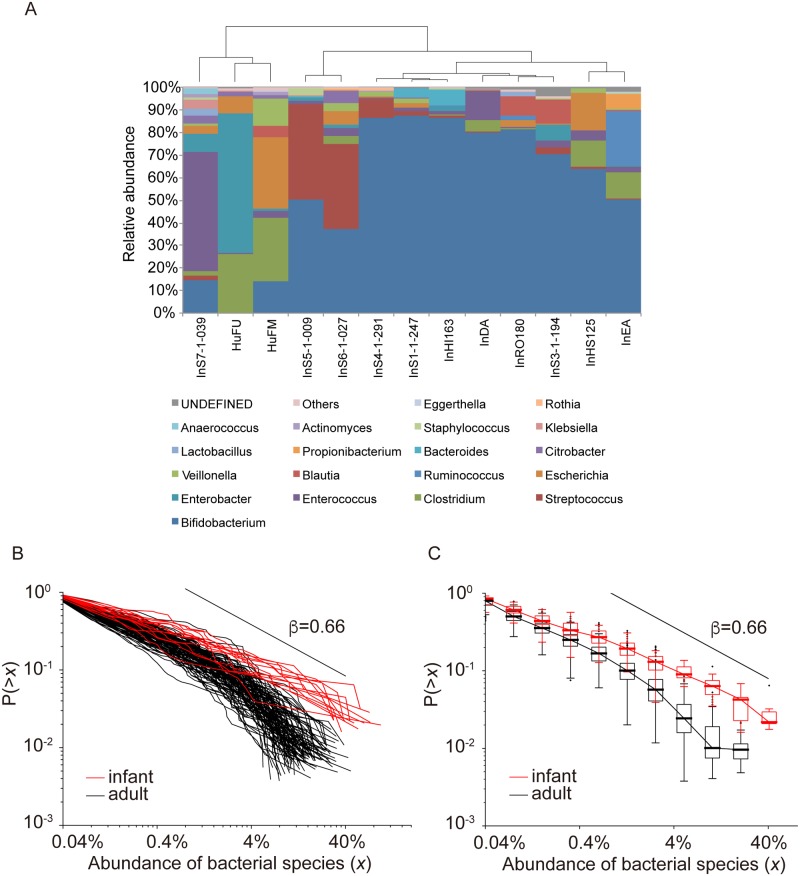
CRADs of the human infant gut microbiome.A: Clustering of the 13 human infant samples at the genus level. Hierarchal clustering is performed at the genus-level abundance of the human infant samples. Each genus is shown in a different color. B: Individual CRADs of gut microbiomes of 13 human infants based on the OTU-level composition. The CRADs of the gut microbiomes of the 13 infants (red) and the 104 healthy Japanese adults (black) are shown. C: Median CRADs of the same samples as those in (B). The CRADs of the gut microbiomes of the 13 infants (red) and the 104 healthy Japanese adults (black) are shown in the boxplot.